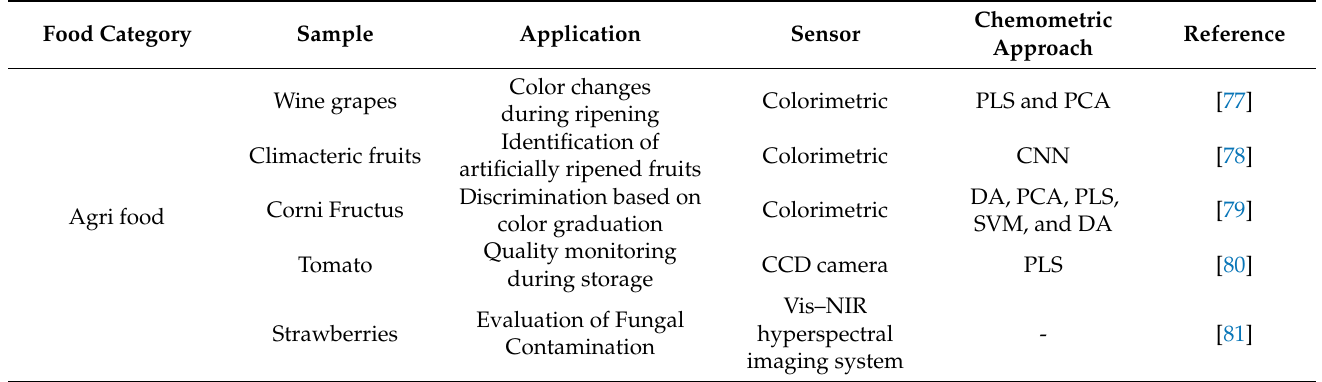
Table 3. Examples of E-Eye application for Food Analysis. CCD: Charge-Coupled Device; NIR: near-infrared; CMOS: complementary metal-oxide semiconductor. ANN: artificial neural